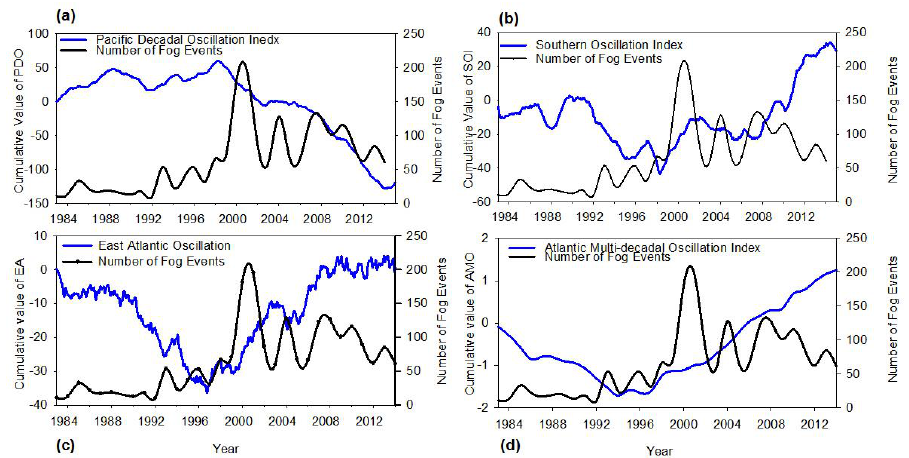
Figure 13. Relationship between climate Indices and fog frequency occurrence in Abu Dhabi City, ( a ) Pacific Decadal Oscillation Index, ( b ) Southern Oscillation Index, ( c ) East Atlantic Oscillation Index, and ( d ) Atlantic Multi-Decadal Oscillation Index.